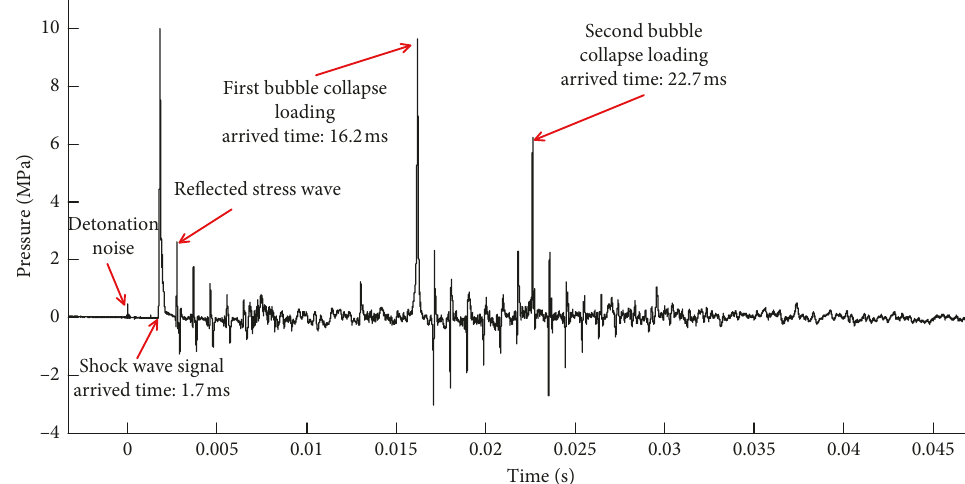
Figure 11: Pressure-time profile recorded by HPB with a 5 mm stand-off.